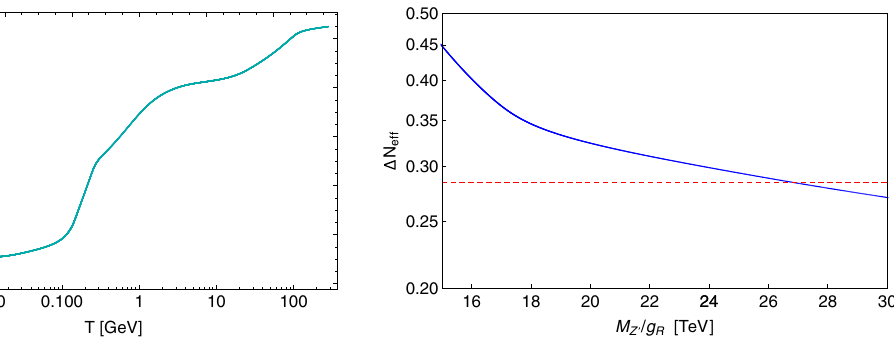
Fig. 17 Ontheleft,weplottheeffectivenumberofdegreesoffreedom as a function of the temperature without including the contribution of the right-handed neutrinos. On the right, we present the contribution